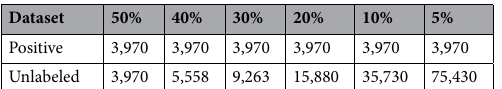
Table 2. Number of examples for each variant of the